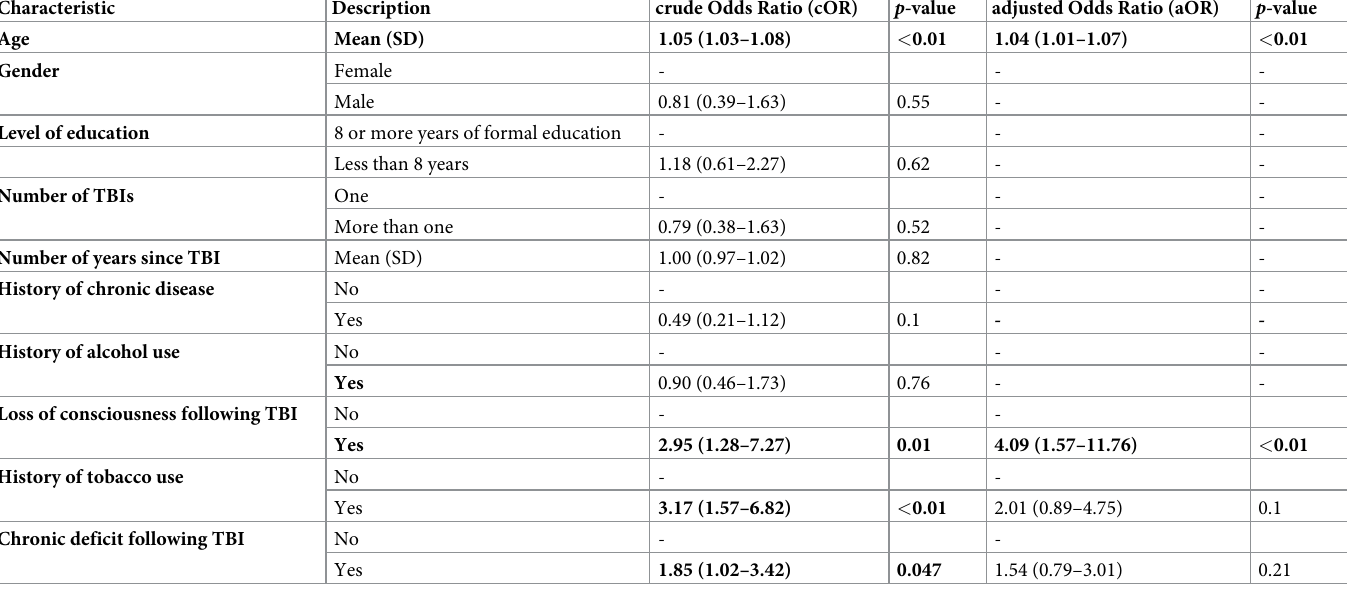
Table 3. Predictors of cognitive impairment among persons with a history of TBI.